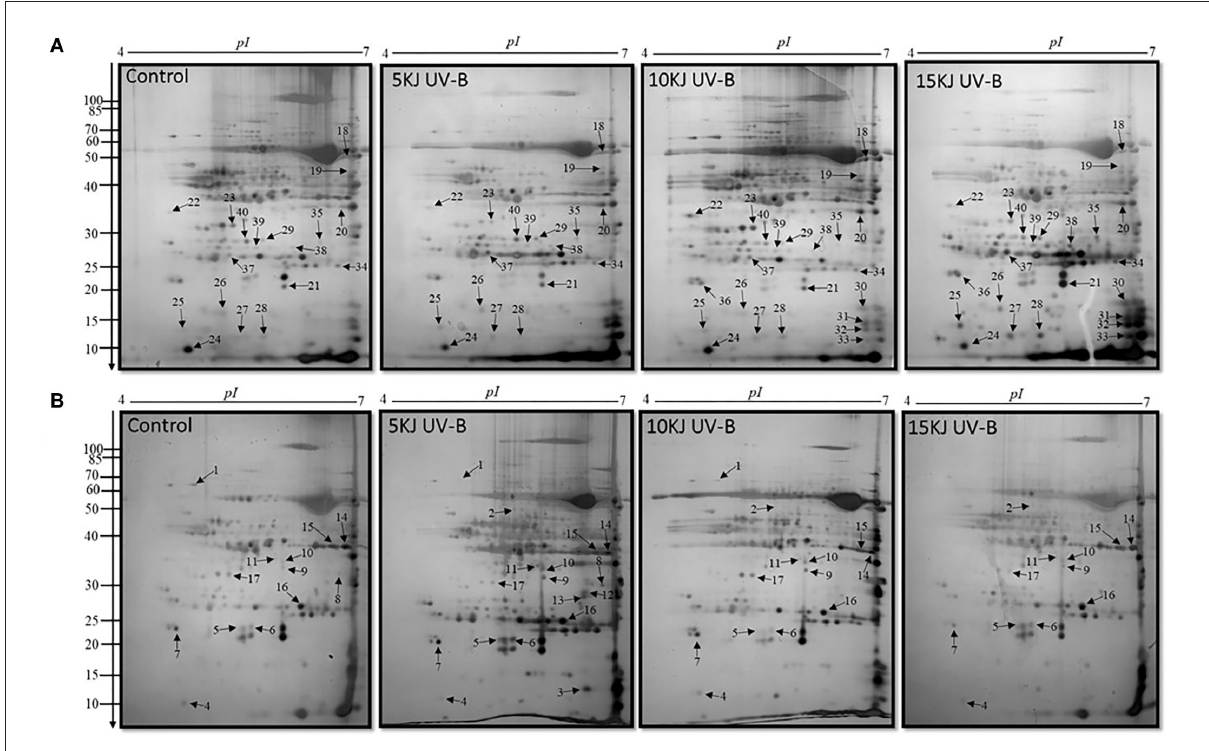
FIGURE2 2D-GE maps of rice leaves proteins during 5, 10, and 15 kJ m − 2 d − 1 UV-B exposure along with control (A) cultivar REX (B) cultivar IR6. Quantitative image analysis revealed 40 differential spots were up and downregulated with silver staining. The black arrowheads showed the number of proteins identified. The numbers at the left of each panel are molecular masses in